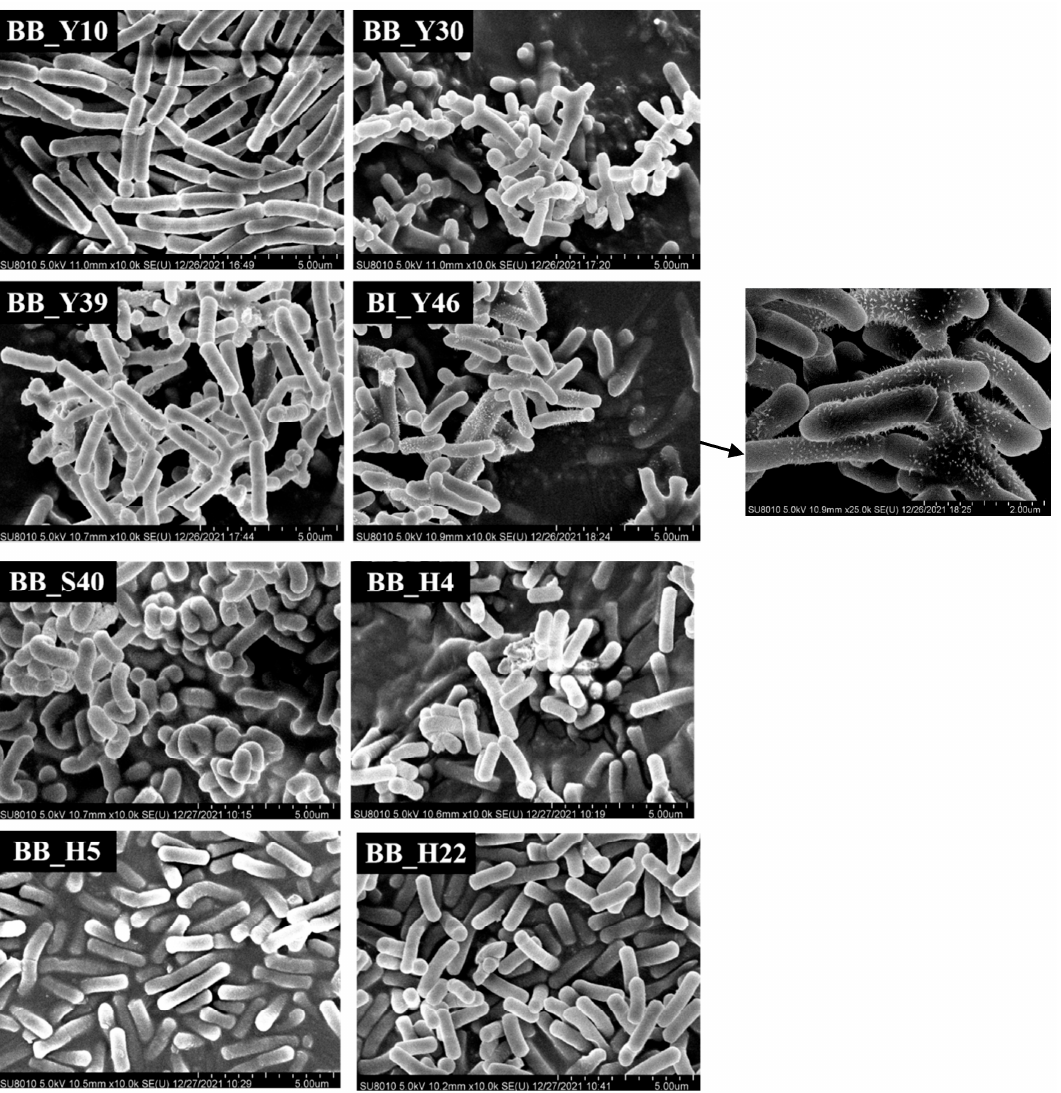
Figure 2. Observation of bifidobacterial morphology using 2 ′ -FL by SEM. BI_Y46 is Bifidobacterium longum subsp. infantis and the other seven strains are Bifidobacterium bifidum (BB_Y10, BB_Y30, BB_Y39, BB_S40, BB_H4, BB_H5, BB_H22).